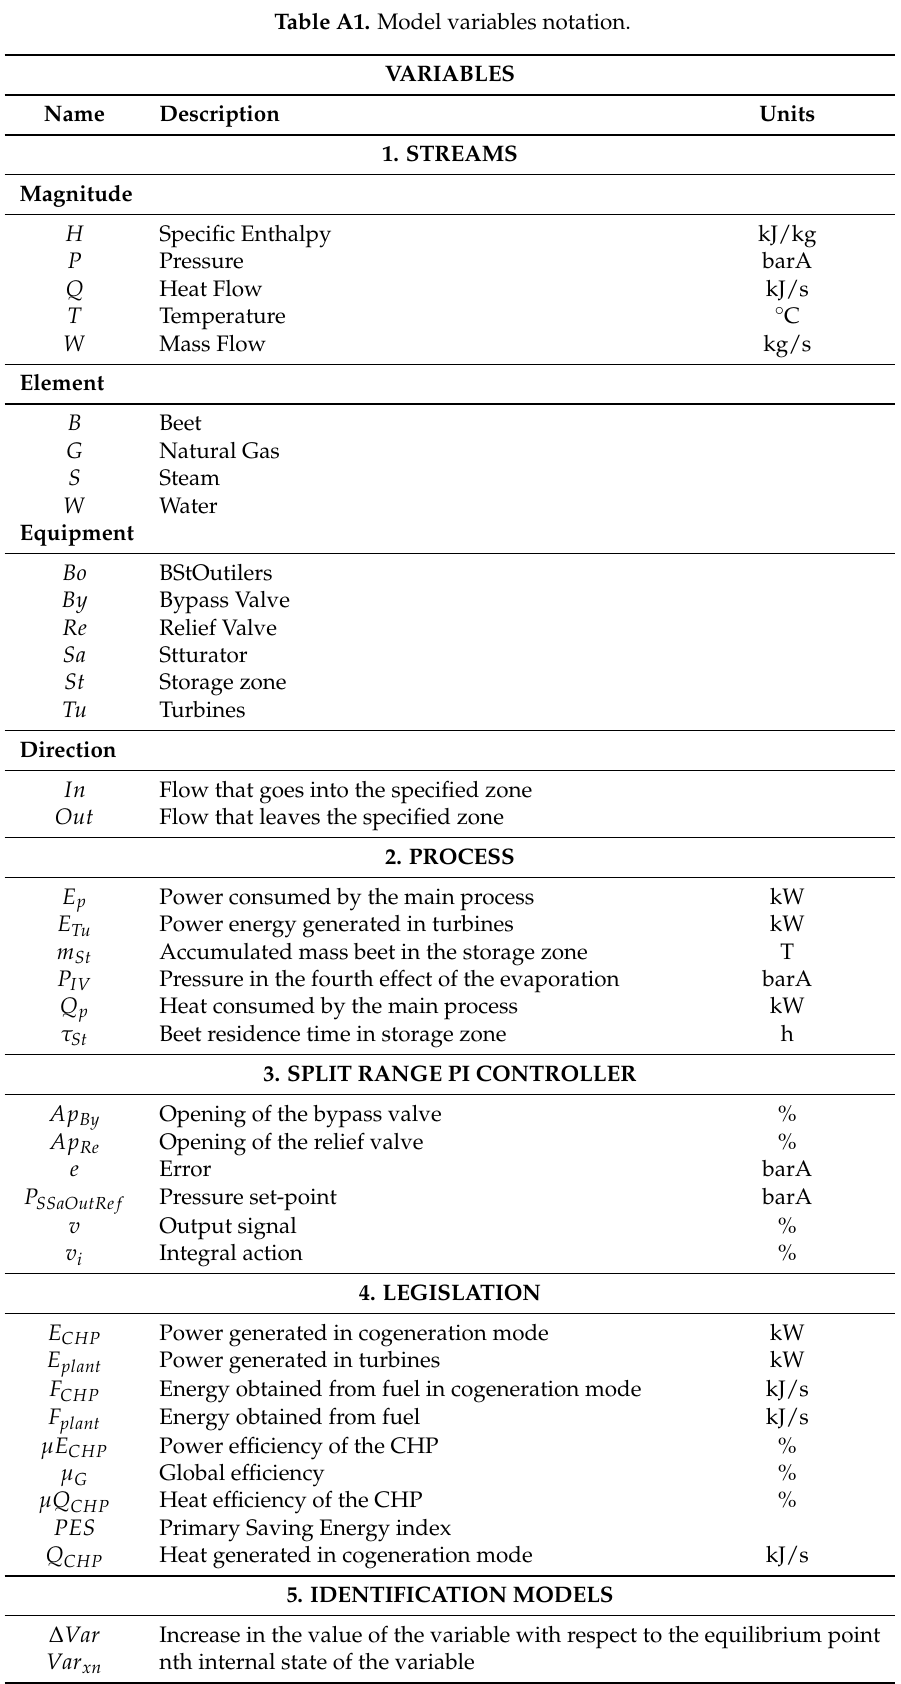
Table A1. Model variables